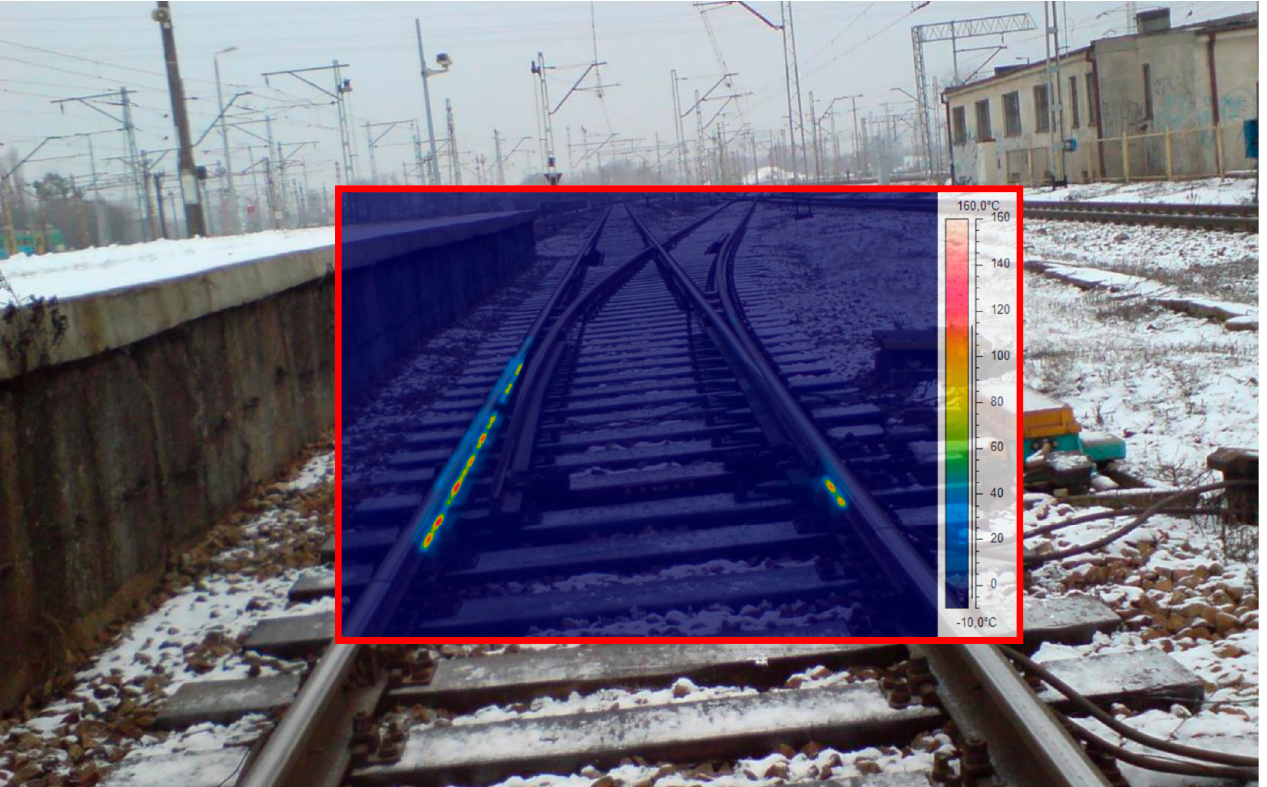
Figure 8. Photo of a fragment of a Rz 200 turnout in the track layout near Warsaw (source: authors).